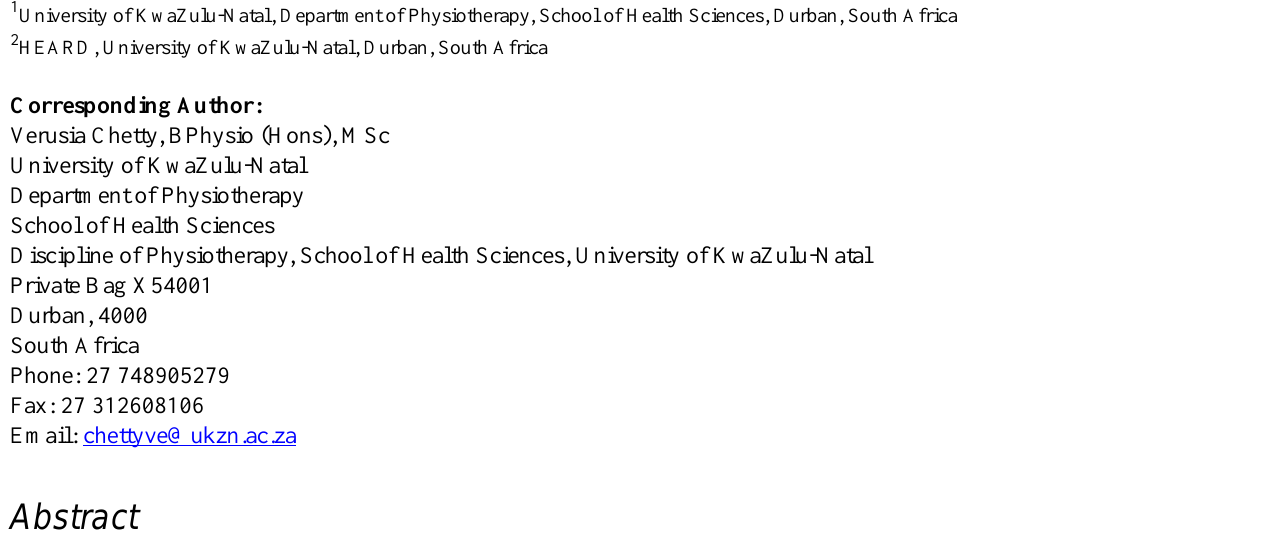
model of care; rehabilitation; HIV; disability; physiotherapist; Delphi